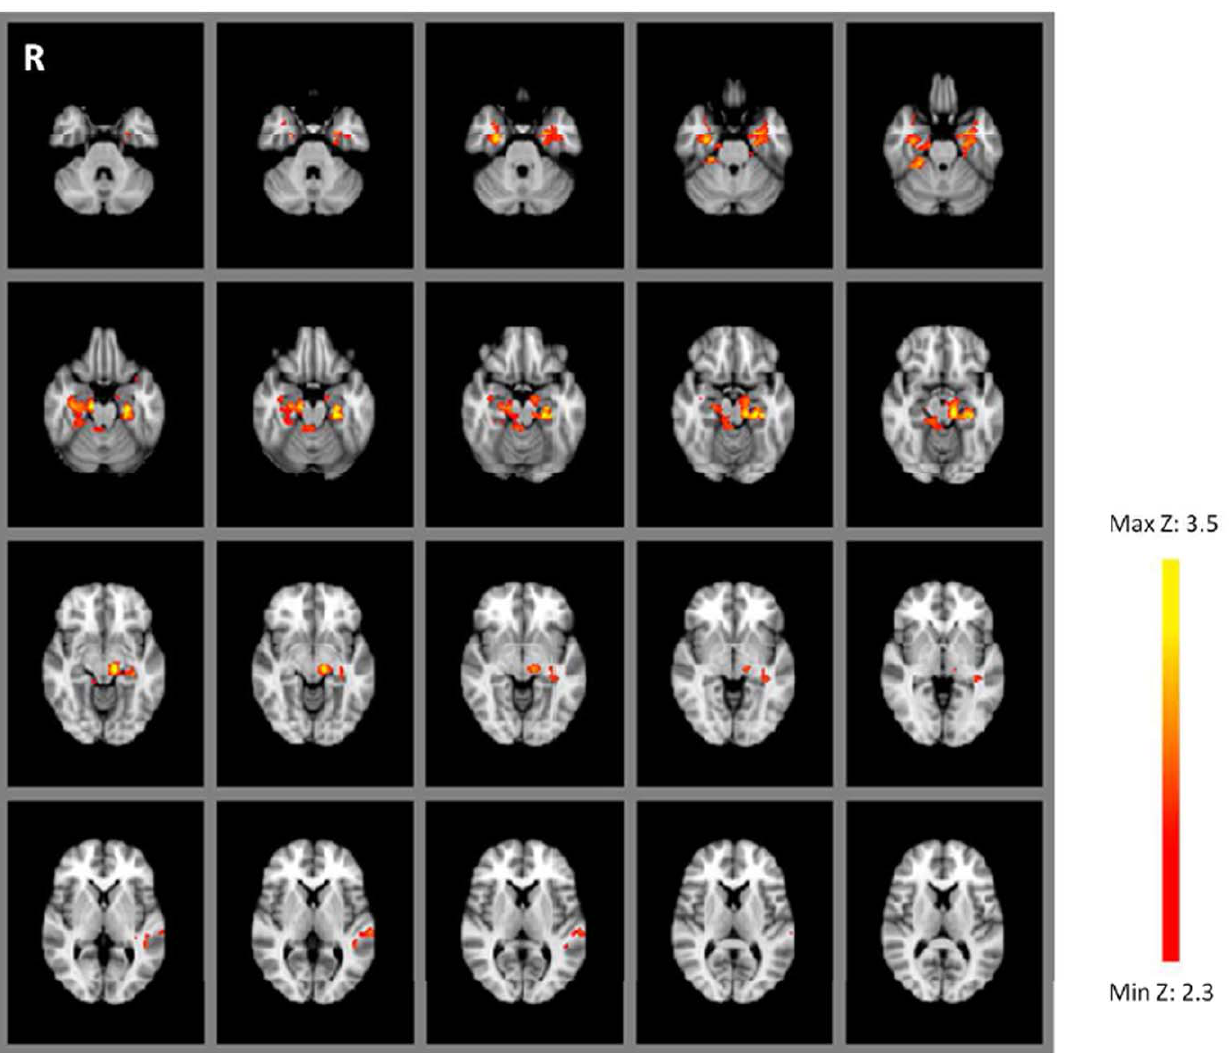
Figure 3. Data from Experiment 1. Percentage signal change in paired repeats relative to the unpaired baseline. Regions displaying attenuation of neural activity in the paired repetition condition relative to baseline during the Primed condition but not the WM condition. Z=2.3, p , .05, corrected for multiple comparisons. Images are in radiological orientation (right=left).